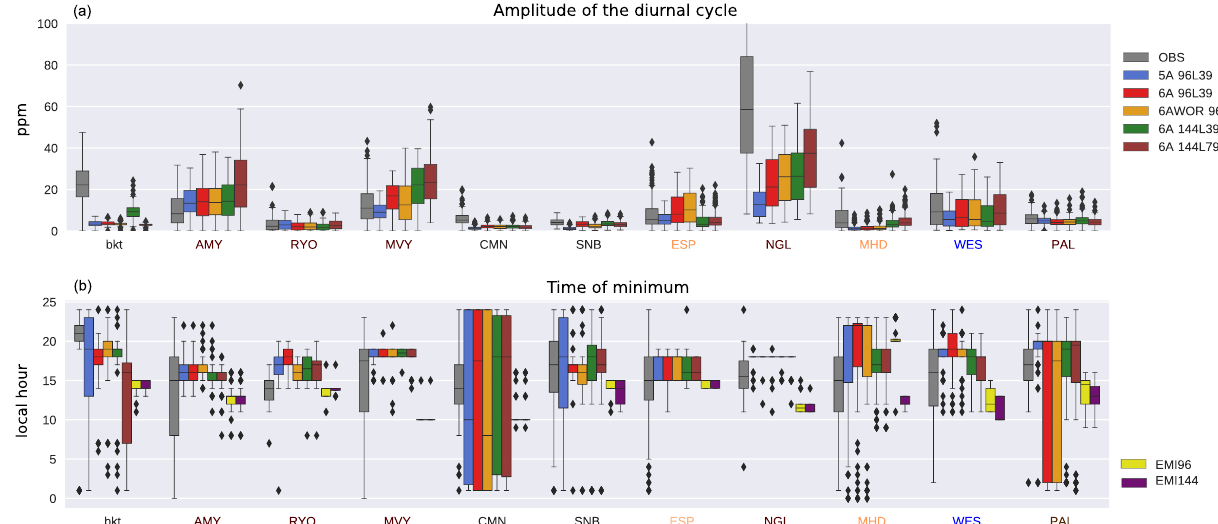
Figure 9. (a) Box plots of the peak-to-peak amplitude (maximum concentration minus minimum concentration) of the mean diurnal cycle for July–September for observed (grey) and modelled (colours) CO 2 for each model simulation during the years 2011–2012. The diurnal amplitude is calculated from the residual between the raw data and the daily mean. The sites are listed on the abscissa. (b) Box plots of time of minimum crossing for each model. The times for the prescribed CO 2 are displayed for both horizontal resolutions in yellow (96 × 95) and purple (144 × 143). Here only the sites with a diurnal amplitude greater than 1ppm are depicted. The code colour for stations is the same as